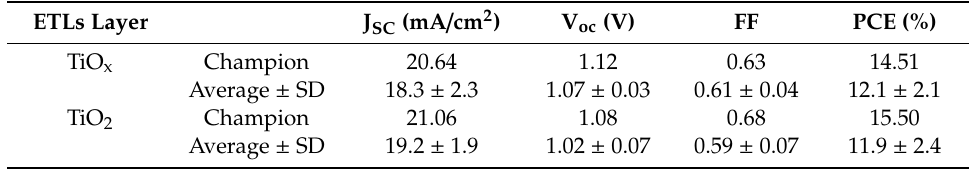
Table 1. Summary of the parameters for the PSCs (FTO-glass / TiO x or TiO 2 / MAPbI 3 / Spiro-OMeTAD / Au). The statistical analysis (average ± standard deviation) was based on the measurements of 18 and 26 individual devices with TiO x and TiO 2 , respectively. Champion refers to the device with the highest PCE. ETLs Layer J SC (mA / cm 2